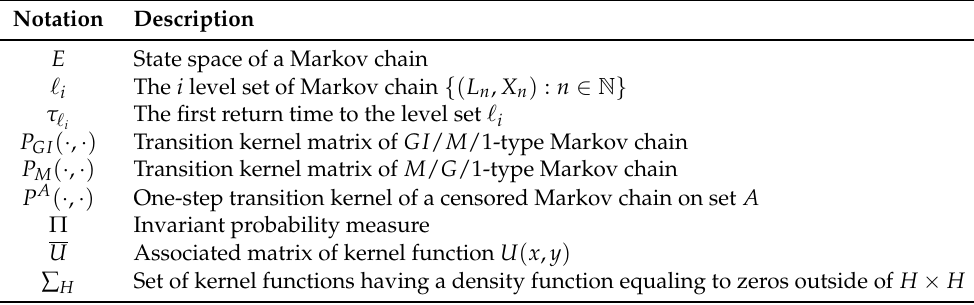
Table A1. Summary of frequently used